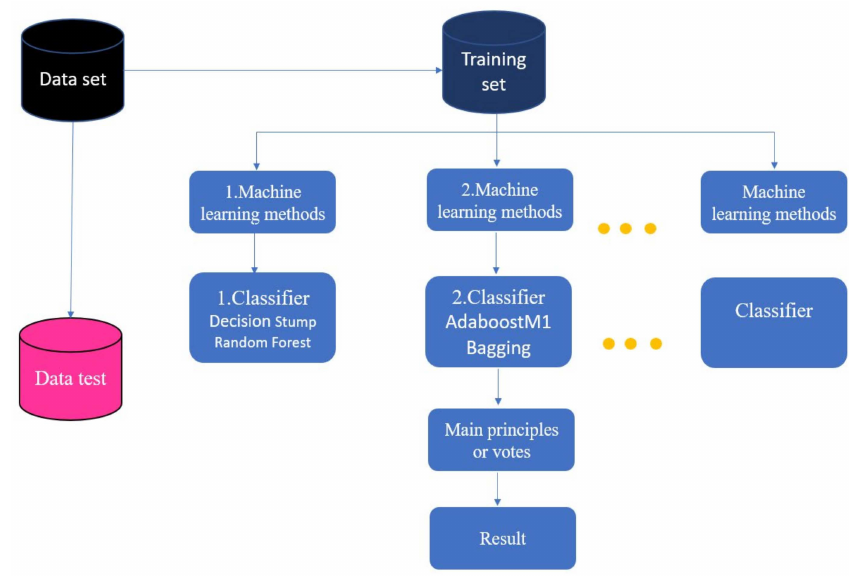
Figure 3. The schematic diagram of the ensemble learning